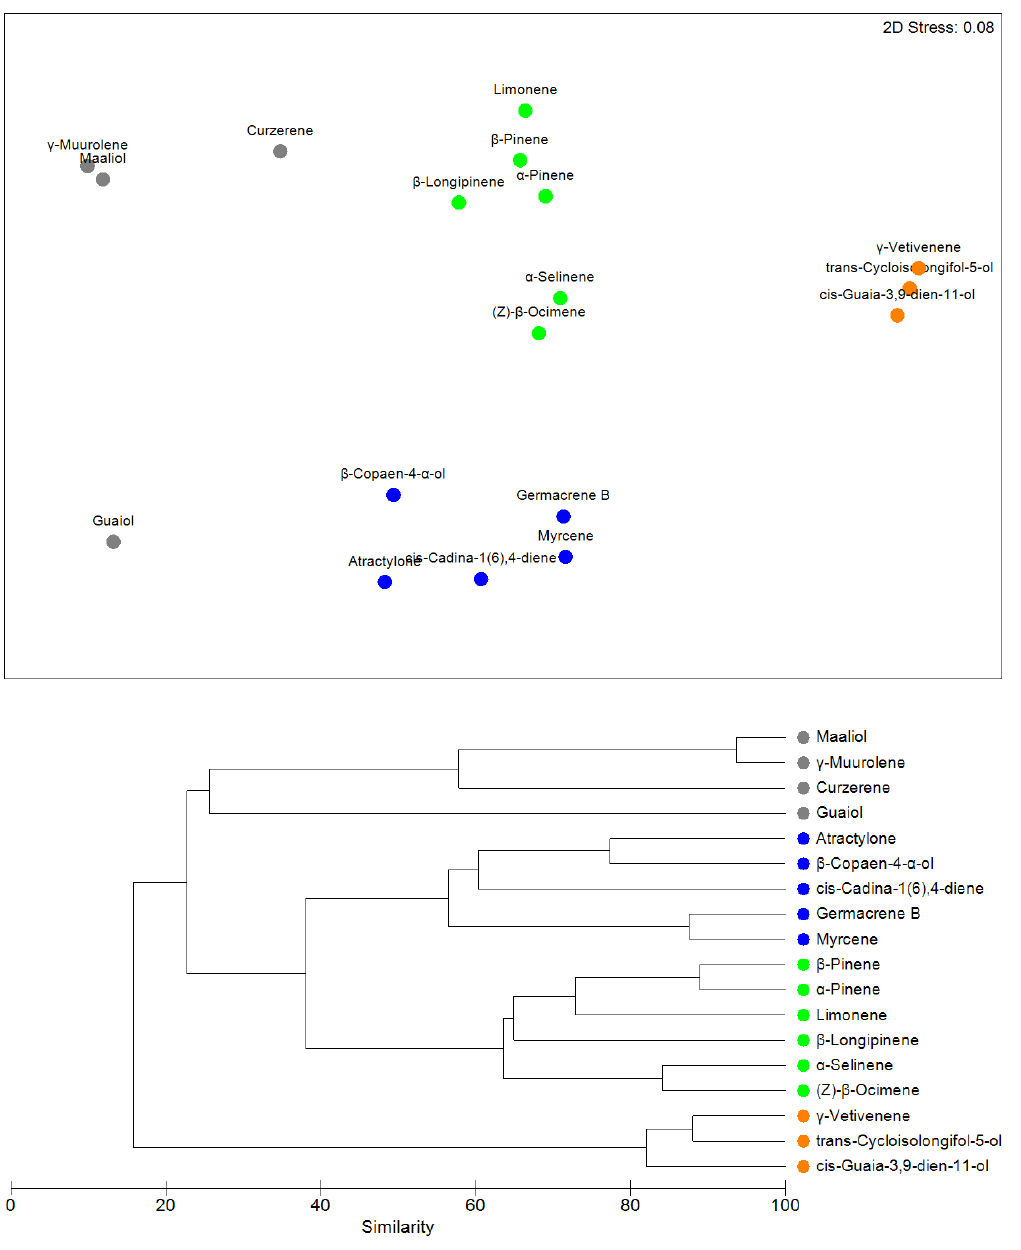
Figure 2. NMDS and Cluster analysis of secondary metabolites in the four localities. L1 Chuquiribamba (Grey circle); L2 Yangana (Green circle); L3 Celica (Blue circle), L4 Colaisaca (Orange circle). The SIMPER routine revealed that not all secondary metabolites contribute equally to establishing the differences in the four localities. We observed that the largest contributions are due to differences in guaiol, cis-cadina-1(6),4-diene, atractylone and germacrene B (Table 7).